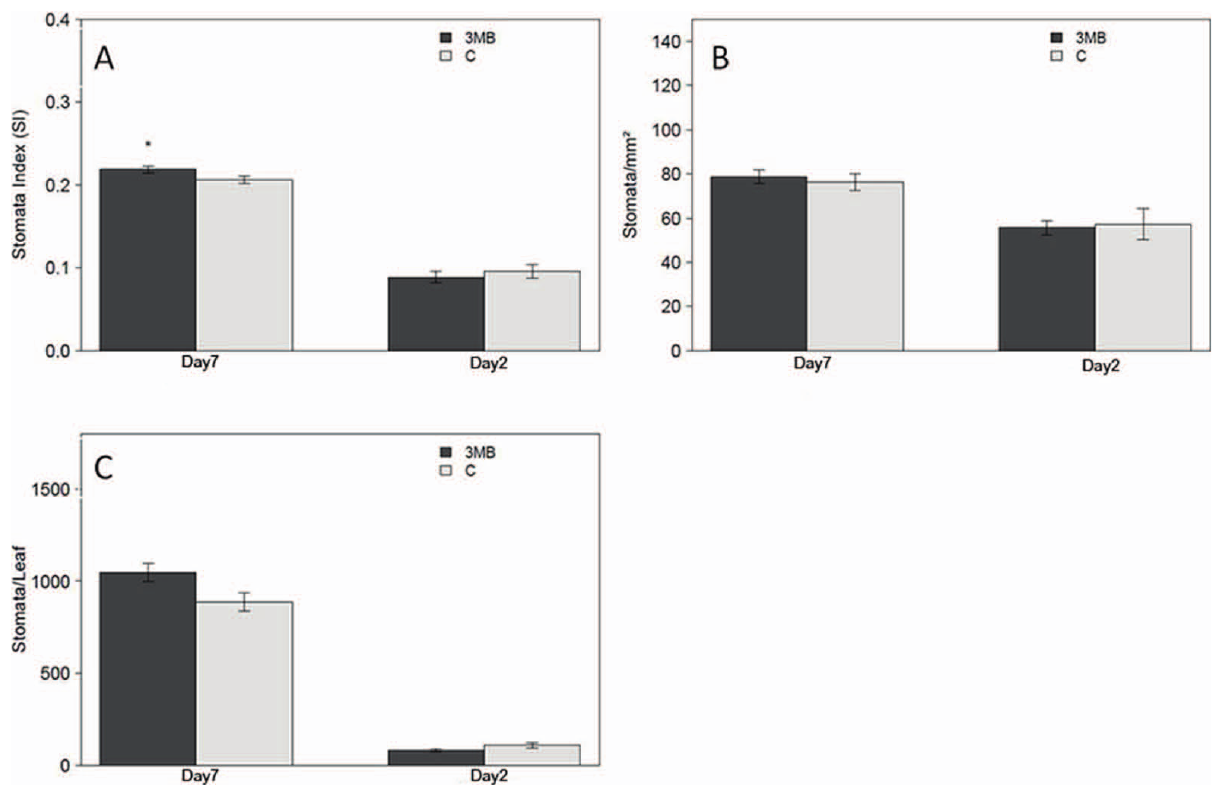
Figure 4. PARP inhibition and its effect on guard cell development. Arabidopsis leaf two was analyzed after two days of transferring the seedlings (day2) or after seven days (day7) either to treatment or control conditions. (A) The stomata index (SI) is shown, calculated by number of stomata divided by number of cells, (B) the number of stomata per mm 2 and (C) the calculated total number of stomata per leaf is presented. In each experiment 4–6 leafs were analyzed and the experiment repeated three times independently (n=12–18). Significant differences (P , 0.05) between treated and untreated plants is indicated by an asterisk.